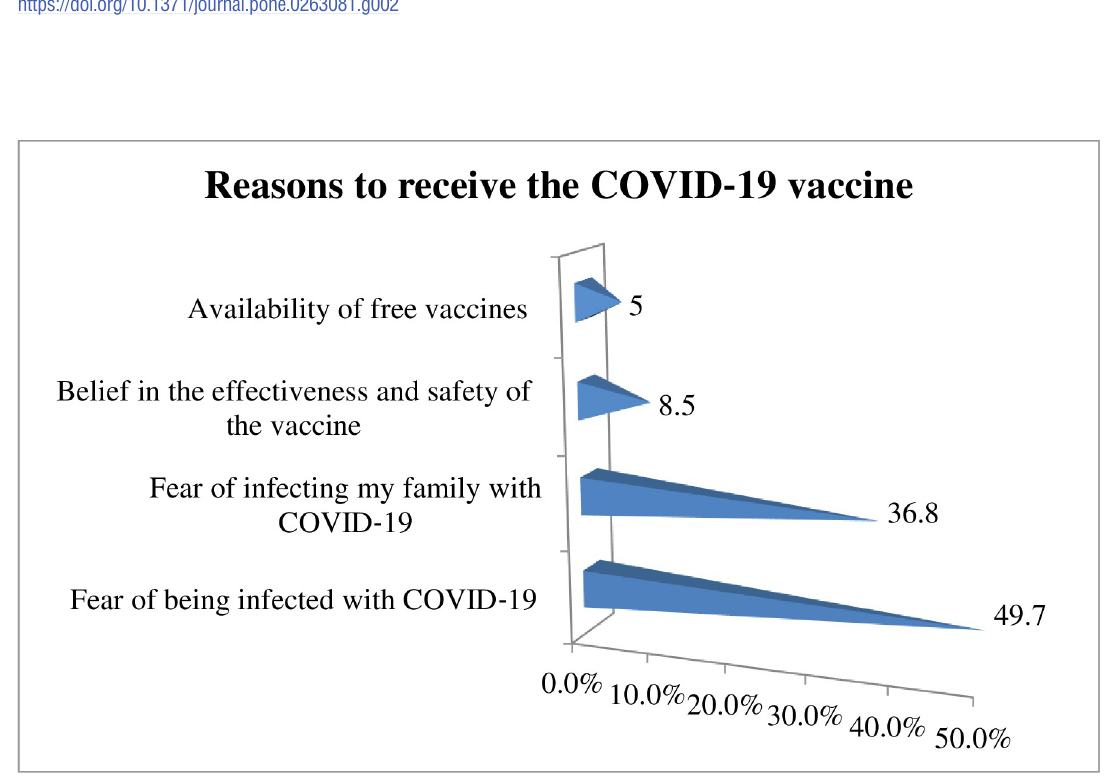
Fig 3. Reasons for willingness to receive COVID-19 vaccine among medical and health science students attending Wolkite University, Ethiopia, 2021 (n = 247).